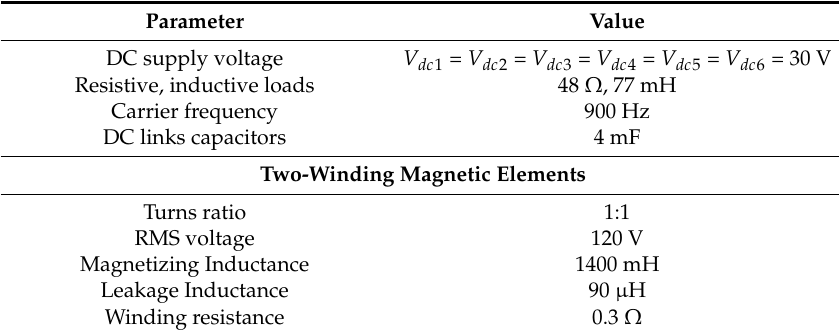
Table 1. Prototype